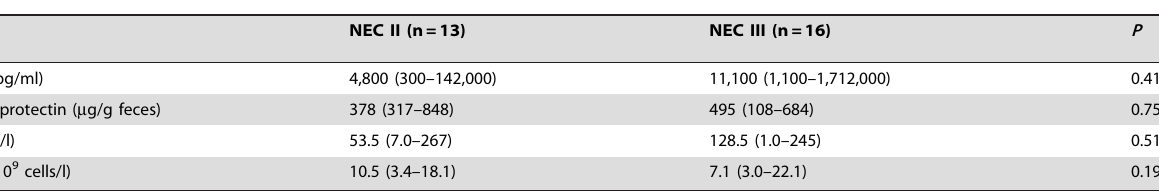
Figure 2B. Platelet levels at one day prior to surgery (S-1) of